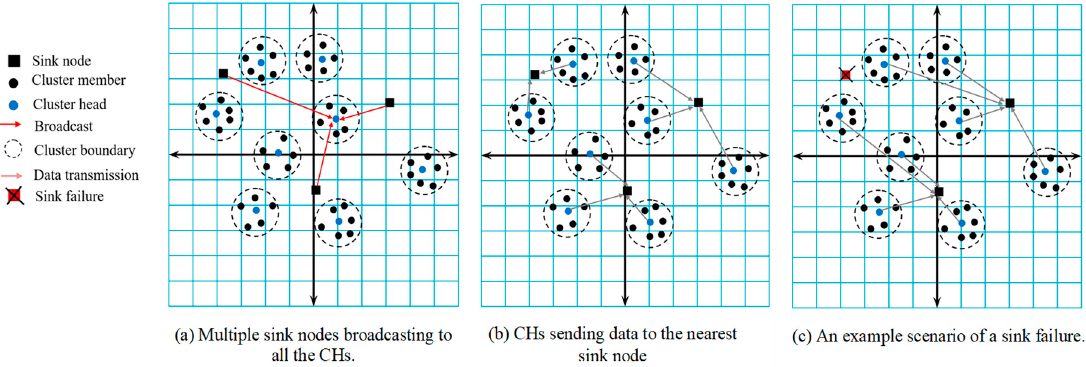
Figure 1. Example network scenarios.